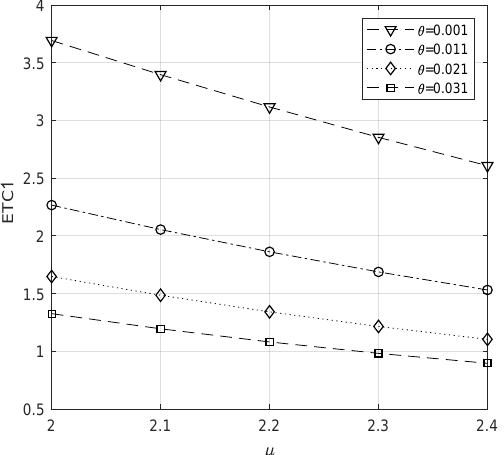
Figure 8. The impact of ETC when θ vs µ for WSAM.